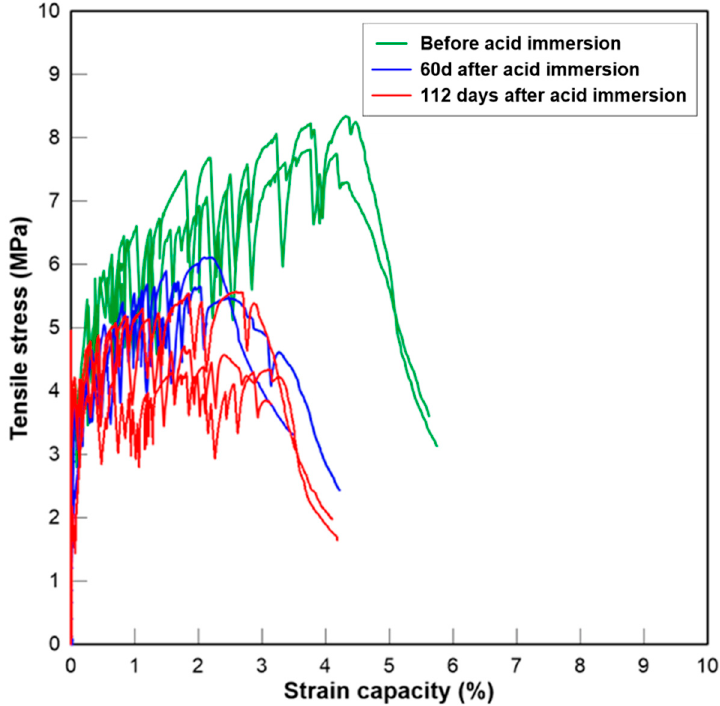
Figure 12. Tensile stress–strain curves of OPC-GGBFS 1.5PE. Table 5. Tensile properties of fibre reinforced mortar before and after sulfuric acid exposure.